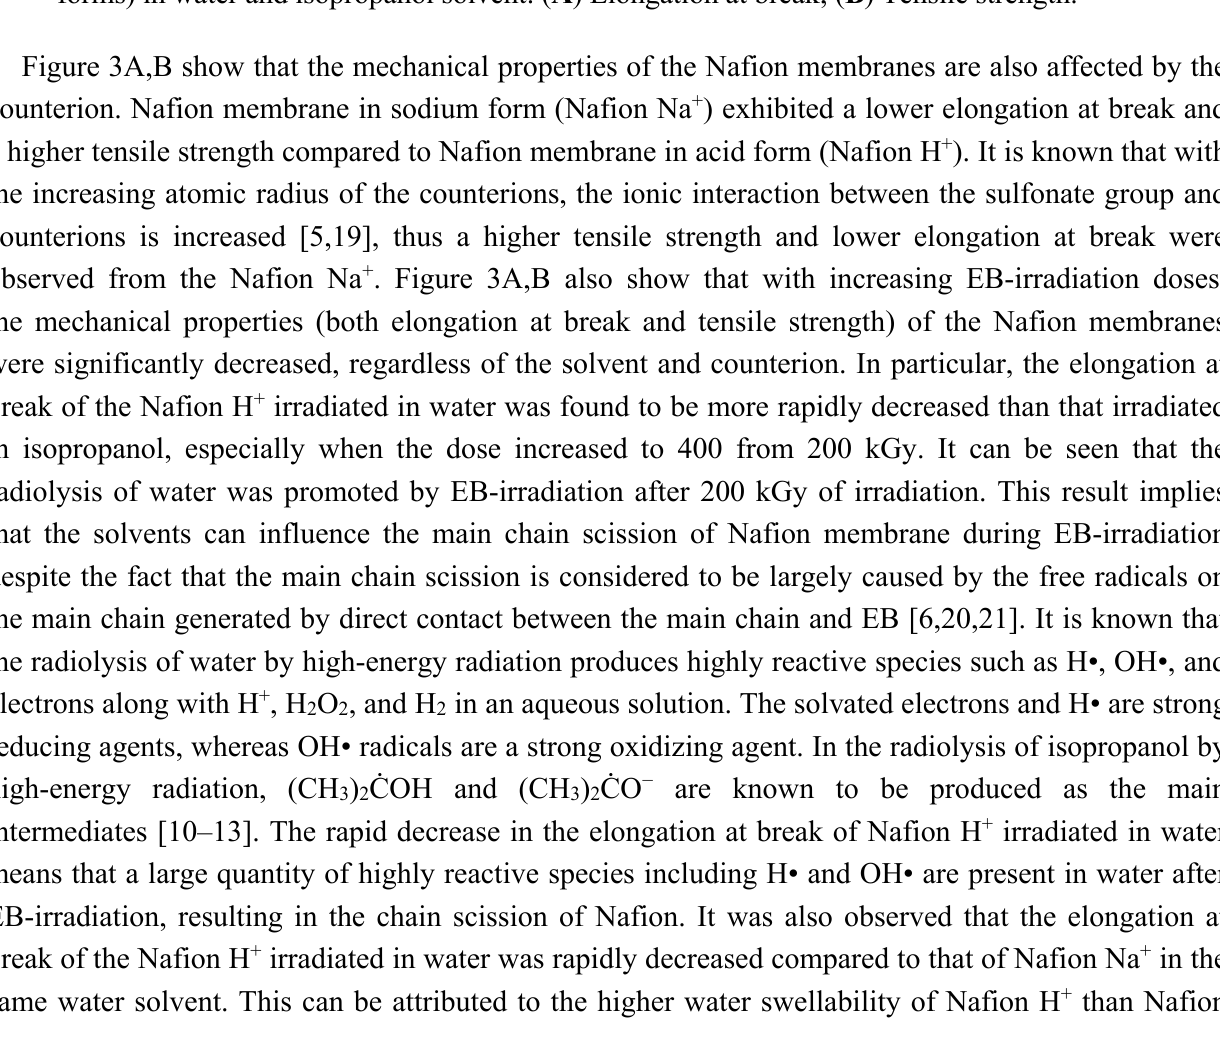
Figure 3. Mechanical properties of EB-irradiated Nafion membranes (both acid and sodium forms) in water and isopropanol solvent: ( A ) Elongation at break; ( B ) Tensile